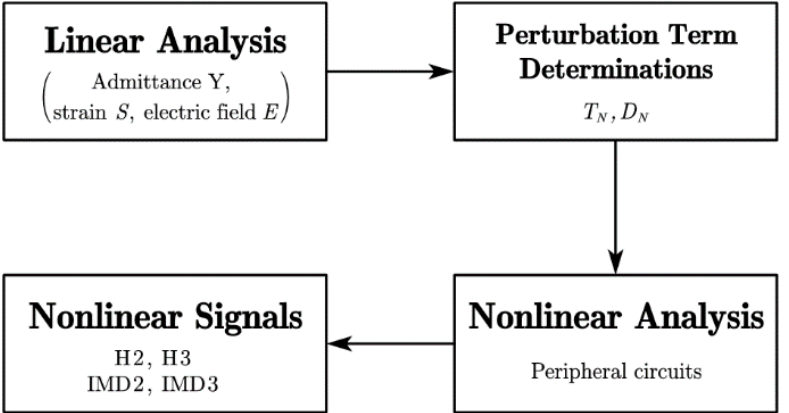
Figure 2. Analysis procedures for simulation of nonlinear signals.